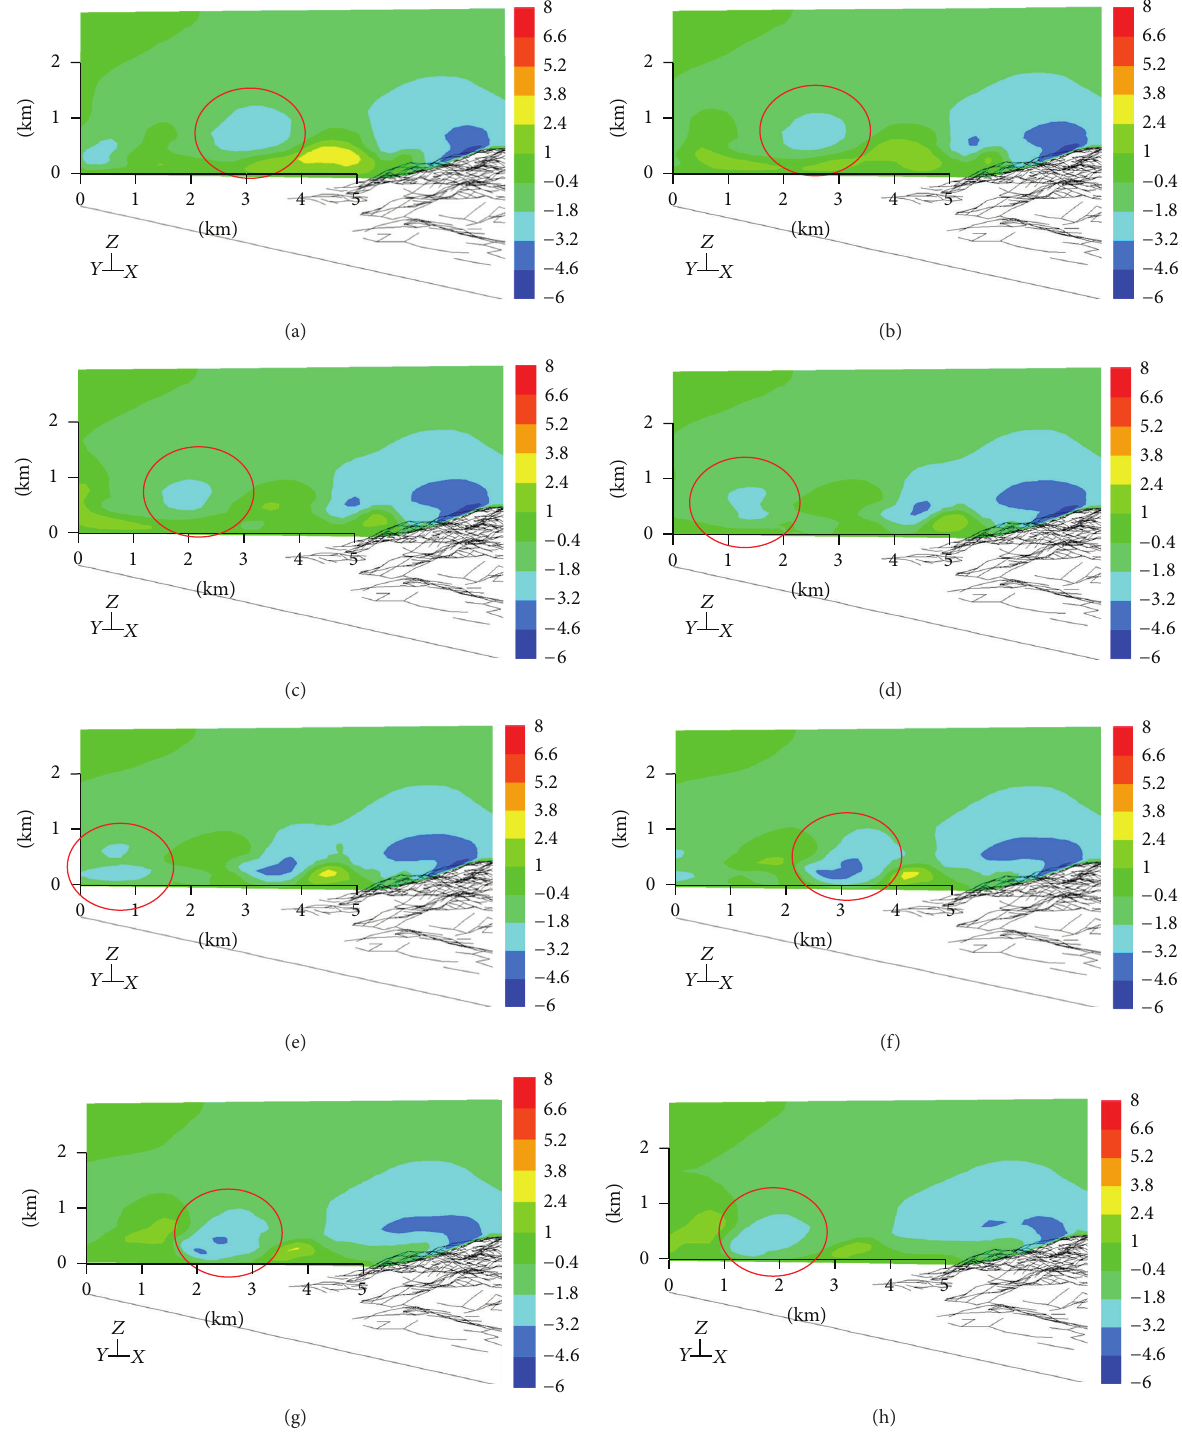
Figure 6: Vertical wind speed component at cross section (unit: m/s, (a) represents the 27th minute of the simulation period with 1-minute intervals between each figure, and the space scale is valid for the cross section